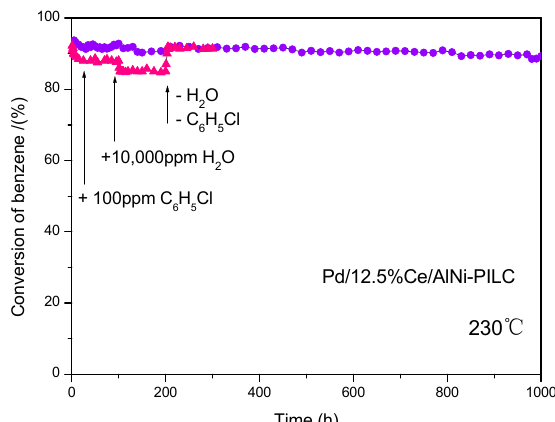
Figure 2. Lifetime test performed for Pd/12.5% Ce/AlNi-PILC at 230 °C.